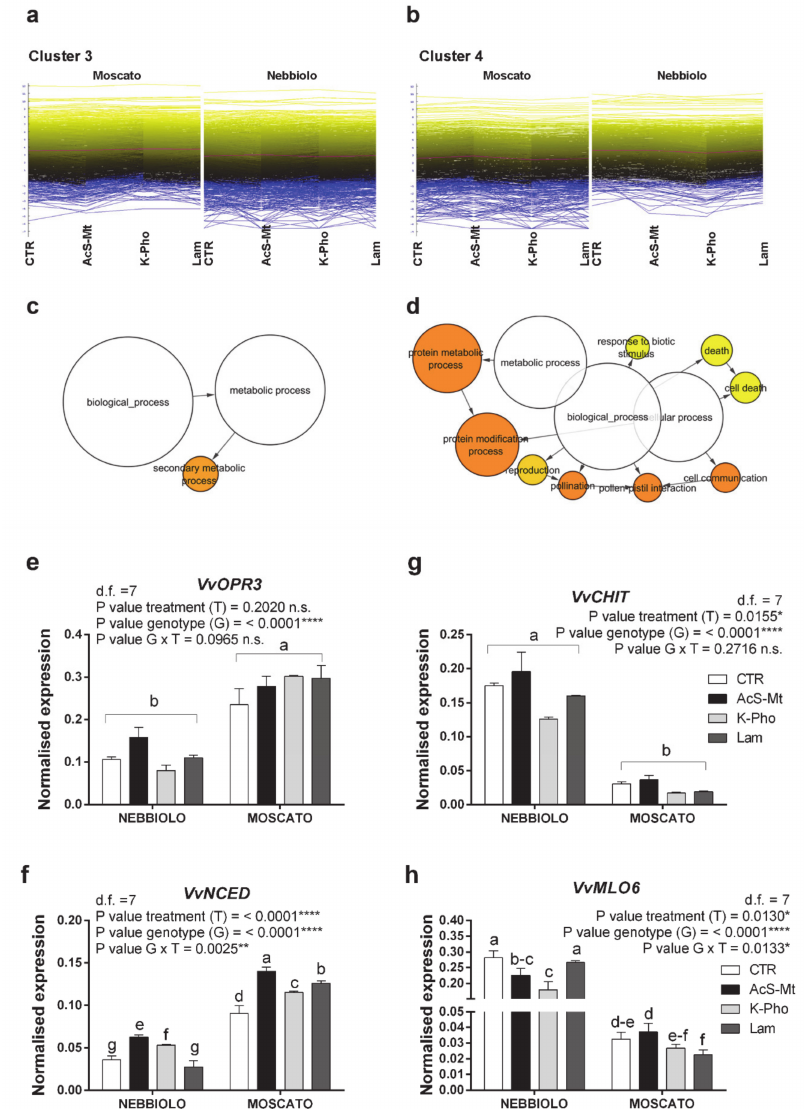
Figure 3. Genotype effect on transcriptional reprogramming of defense responses. ( a , b ) Output of HCL (Hierarchical Clustering) analysis conducted on RNAseq data. Clusters of differentially expressed genes (DEGs) mainly upregulated in ‘Moscato’ ( a , cluster 3) or ‘Nebbiolo’ ( b , cluster 4) leaf transcriptomes. ( c , d ) Significant enriched GO biological functional categories identified for each group of genes belonging to ( c ) cluster 3 and ( d ) cluster 4 using Cytoscape with the BINGO plug-in and listed according to their enrichment p -value ( p < 0.05). ( e – h ) Results of candidate gene expression analysis performed by RT-qPCR assay. Expression profiles of key genes belonging to cluster 3 ( e - VvOPR3 , VIT_11s0016g01230; f - VvNCED , VIT_19s0093g00550), and cluster 4 ( g - VvCHIT , VIT_04s0008g00140, h - VvMLO6 , VIT_08s0040g02170) analyzed in leaf samples taken from ‘Nebbiolo’ and ‘Moscato’ plants artificially inoculated with Erysiphe necator and then untreated (CTR) or treated with acibenzolar-S-methyl (AcS-Mt), potassium phosphonate (K-Pho), andlaminarin(Lam). Ubiquitin( VvUBI )andActin( VvACT1 )geneswerebothusedasendogenous controls for the normalization of transcript levels. Significance of genotype, treatment, and genotype × treatment (G × T) interaction was assessed by Tukey’s HSD test for all p values and the corresponding results are given above each graph in the figure panel; *, **, **** indicate p ≤ 0.05, p ≤ 0.01, and p ≤ 0.0001, respectively; n.s. = not significant. Lower case letters above bars are reported when the G × T interaction and / or Genotype (G) main effects are statistically significant as attested by Tukey’s HSD or Student’s t -test, respectively. Error bars represent SE. Three independent biological replicates with three technical replicates each were used for the